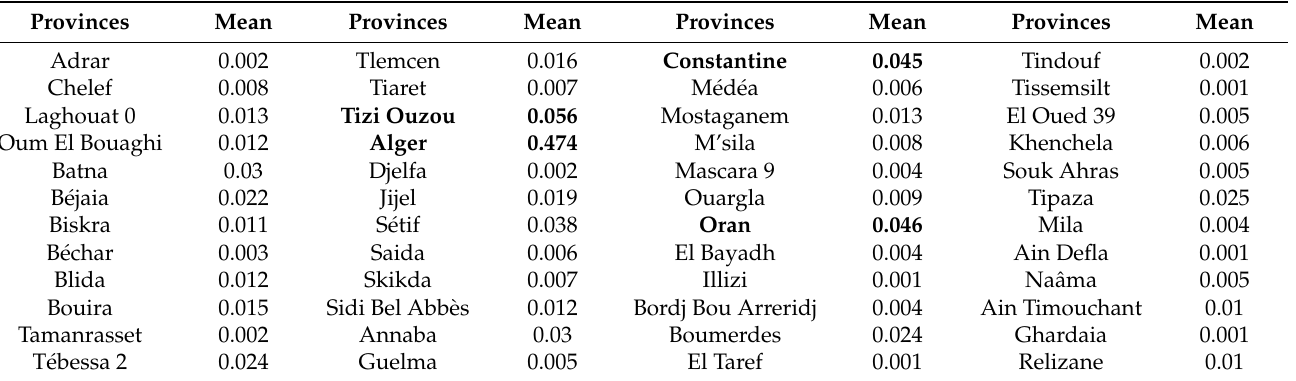
Table 1. Mortality rate due to COVID-19 in the provinces 1